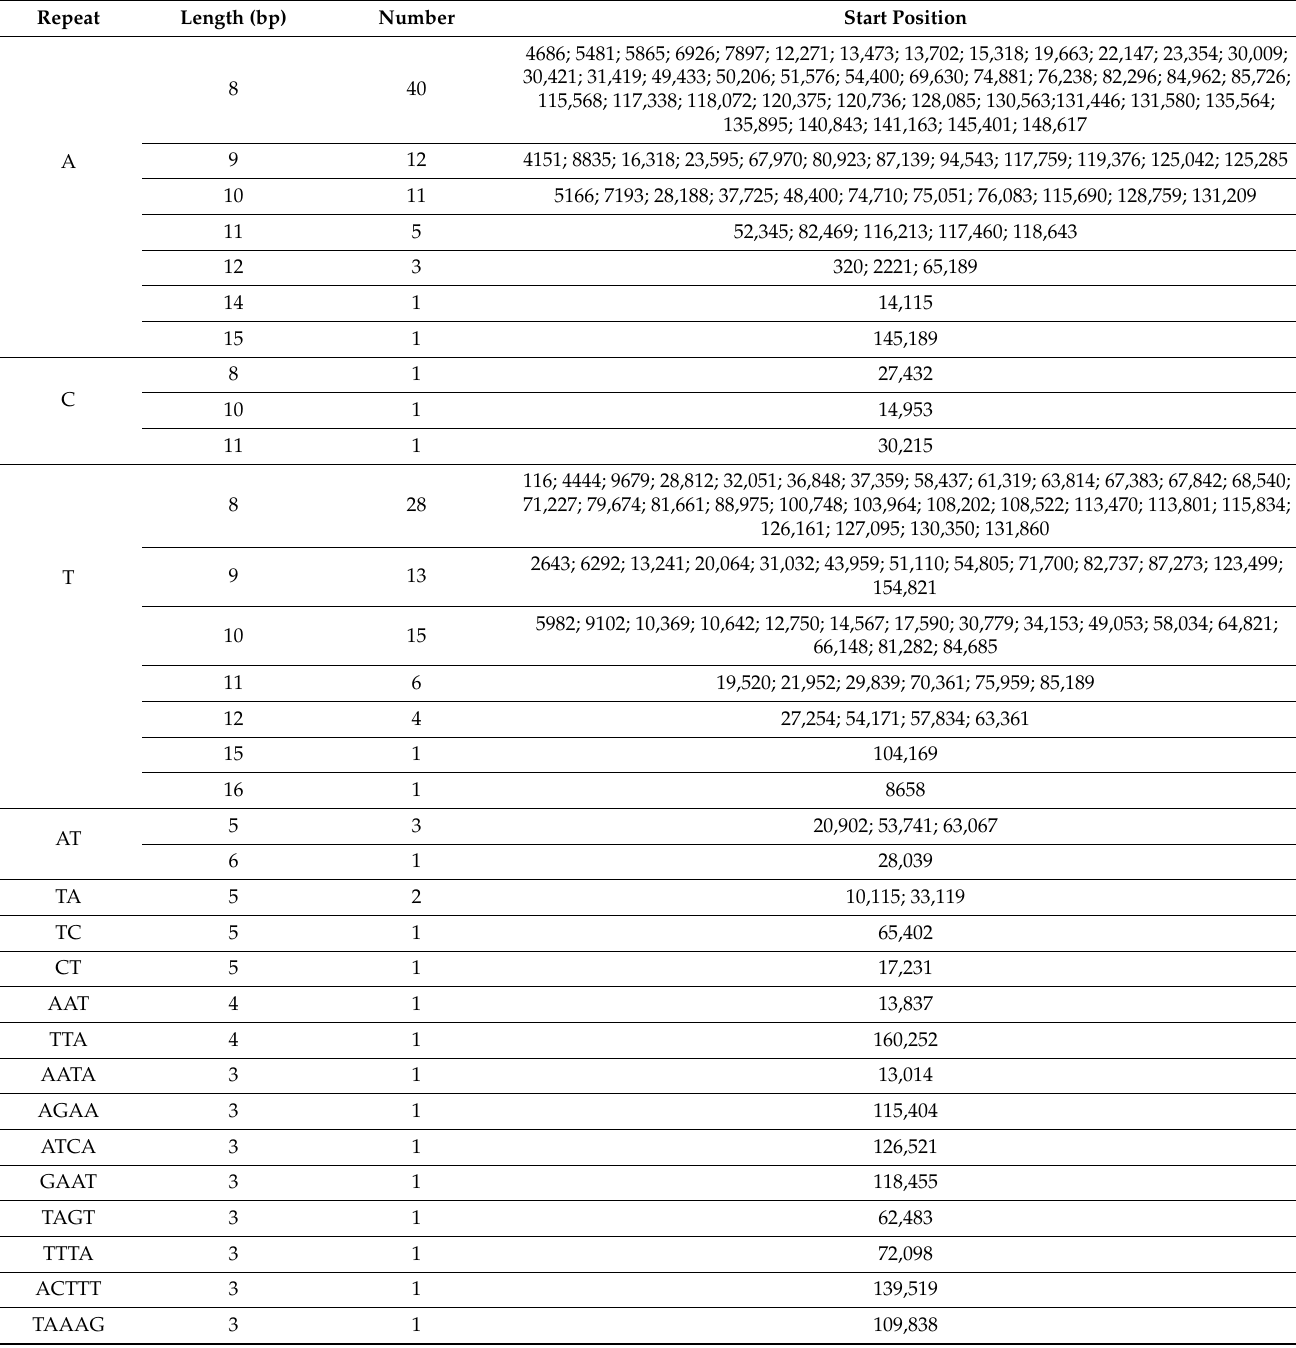
Table 7. Simple sequence repeats in the chloroplast genome of A. fruticosum